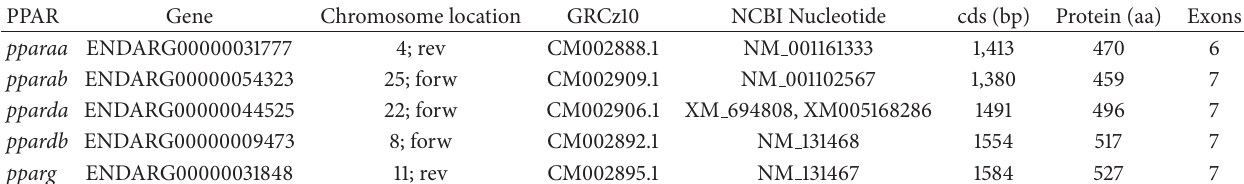
Table 2: Location and characteristics of the PPAR genes in zebrafish genome (GRCz10, Havana, and